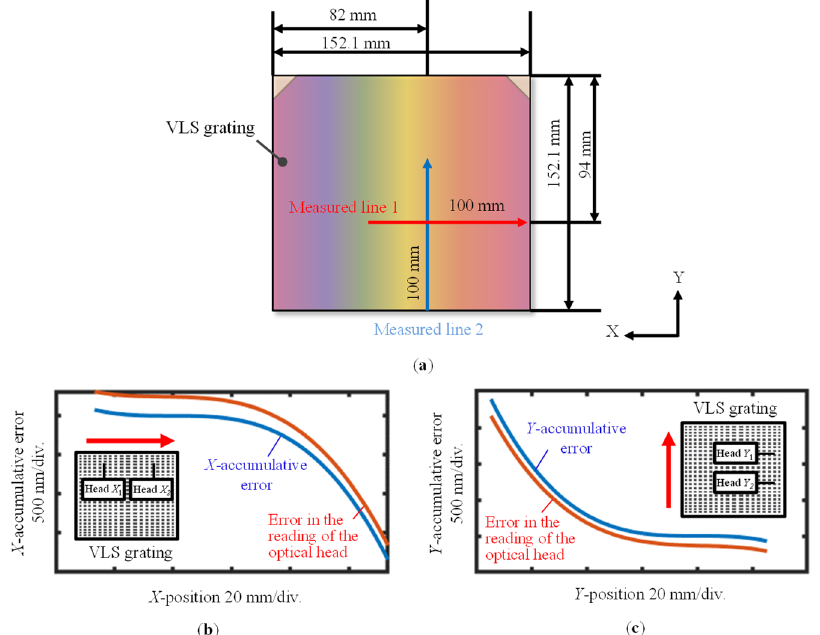
Figure 18. Measurement of the encoder errors of the absolute planar encoder and the comparison results: ( a ) Scanning lines along the VLS grating; ( b ) X -direction comparison result; ( c ) Y -direction comparison result.